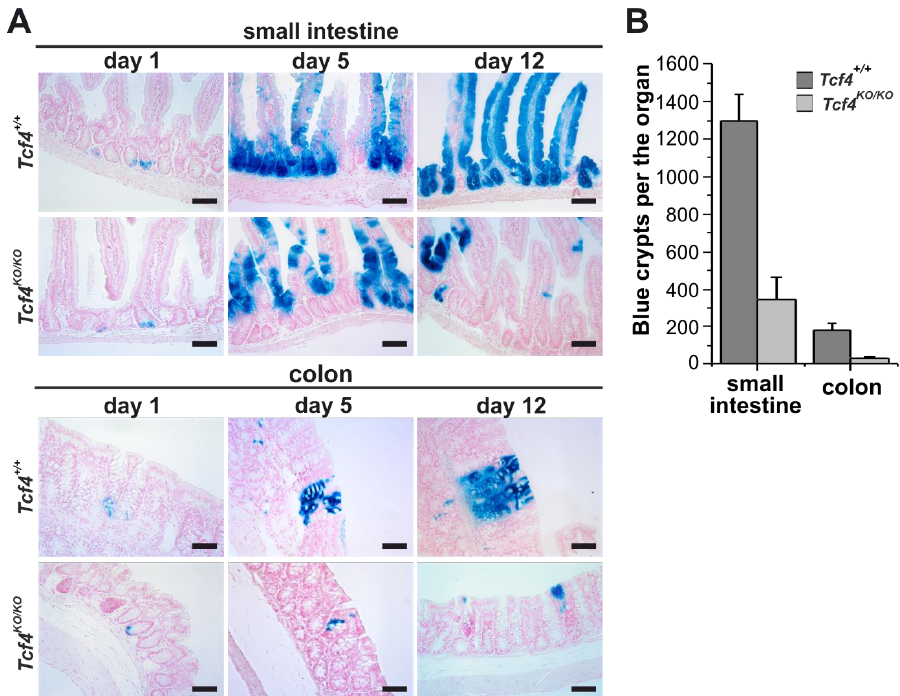
Figure 4. Depletion of the Tcf4 -deficient cell clones from the intestinal epithelium. ( A ) Lineage tracing in the small intestine and colon of Tcf4 +/+ Rosa26R-lacZ Lgr5-CreERT2 ( Tcf4 +/+ ) and Tcf4 flox5/flox5 Rosa26R-lacZ Lgr5-CreERT2 ( Tcf4 KO/KO ) mice at indicated time points after tamoxifen administration. The tissue sections were stained with X-gal to visualize the lacZ-expressing cells (blue color). Specimens were counterstained with nuclear fast red. Scale bar: 0.15 mm; ( B ) Quantification of labeled crypts present in the small intestinal and colonic epithelium 12 days after tamoxifen administration. Four animals of each genotype were analyzed; all blue crypts in the middle portion of the small intestine and colon were counted; error bars indicate SDs. Scale bar: 0.15